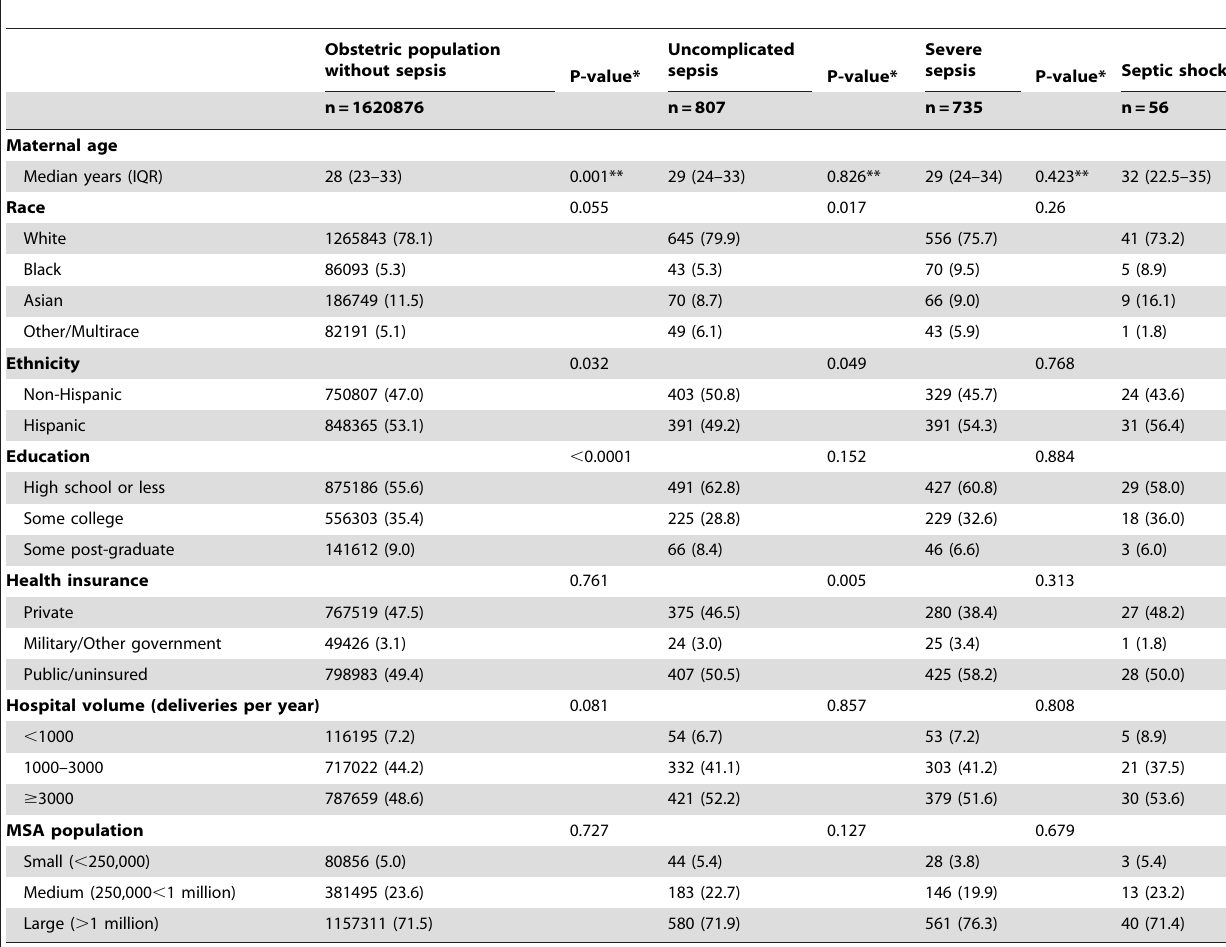
Table 1. Demographic characteristics of non-sepsis obstetric population compared to women with uncomplicated sepsis, compared to severe sepsis, compared to septic shock in California